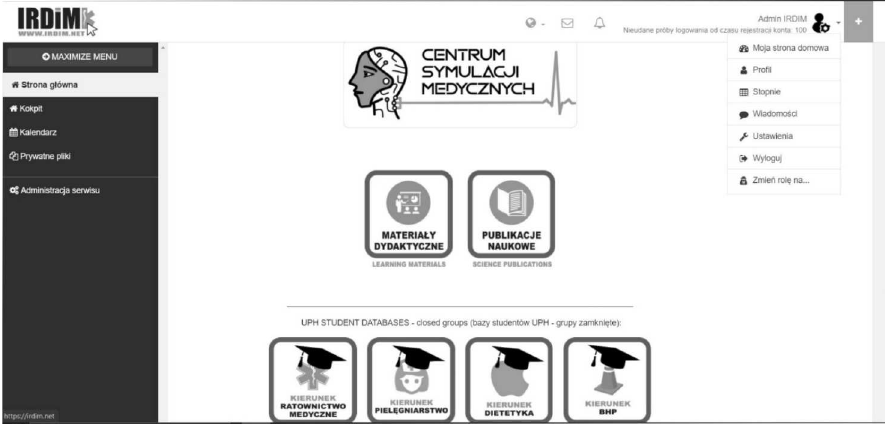
Figure 2. IRDIM platform interface